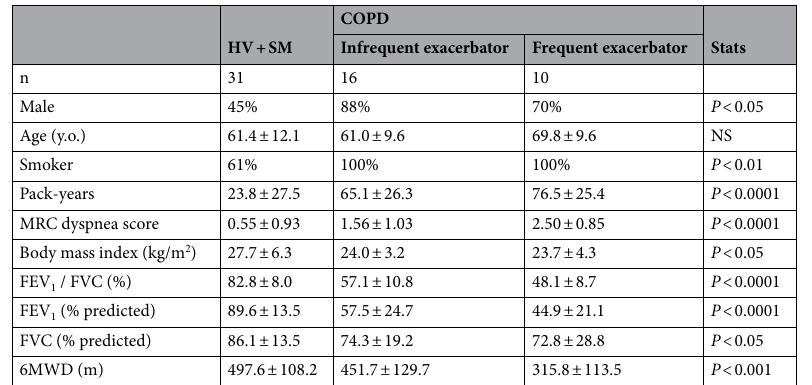
Table 2. COPD patient characteristics for serum study. Data are expressed as mean values ± SD. Frequent exacerbator is defined as patients having two or more exacerbations in 1 year. HV healthy volunteers, SM smokers, MRC Medical Research Council, 6MWD six minute walk distance.